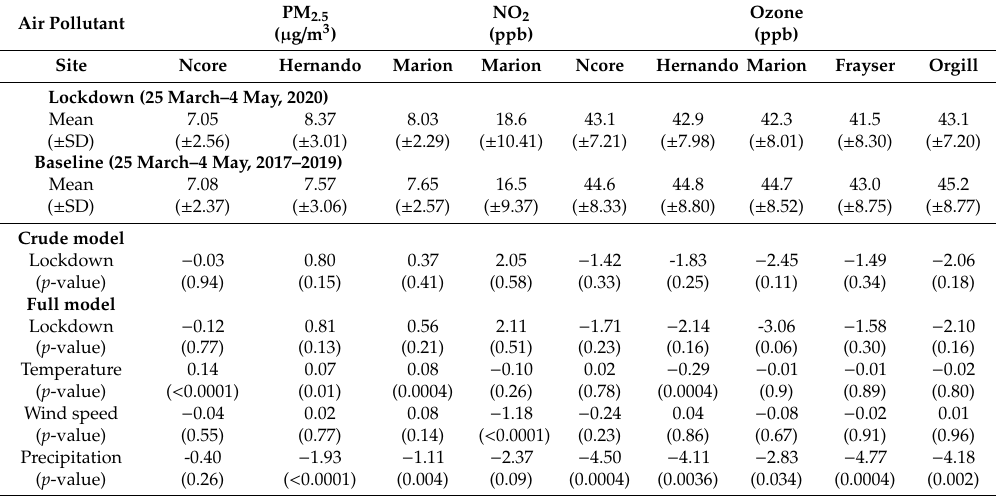
Table 1. Comparisons of PM 2.5 , NO 2 , and ozone concentrations during the lockdown and baseline periods.